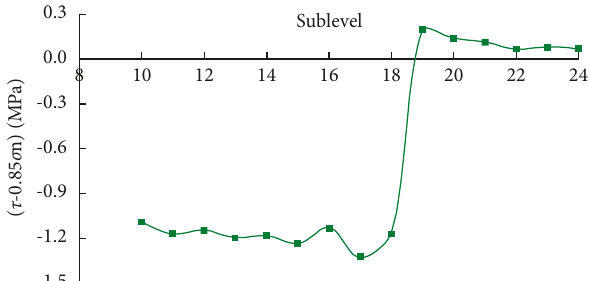
Figure 14: The sliding property of fault F4 varies with the mining depth.